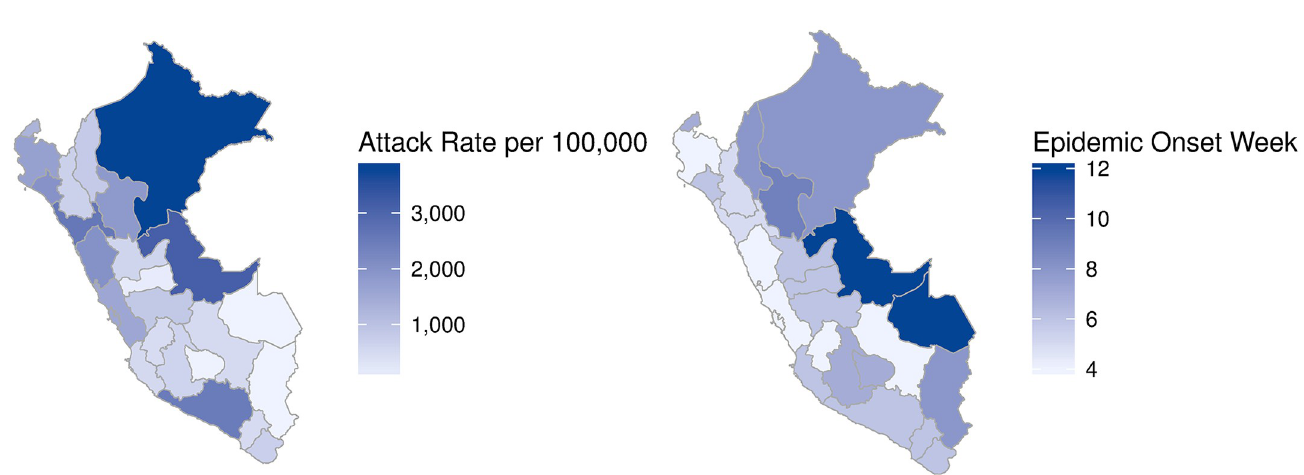
Fig 4. a) Cholera attack rates per 100,000 for Peruvian departments in 1991. The highest attack rates occurred in the jungle region. Coastal departments also showed consistently high attack rates. b) Map showing week of epidemic onset by department. Darker regions experienced a later onset, defined as the first week in 1991 with reported cholera cases. The map was created using the function admin1_choropleth using R.